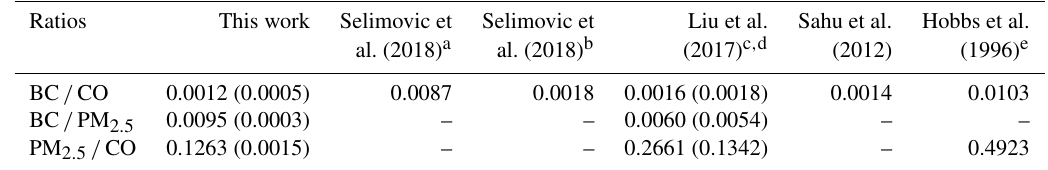
Table 2. Time-weighted study-average enhancement ratios (gg − 1 ratioed to CO) compared to emission ratios reported in other studies. Ratios